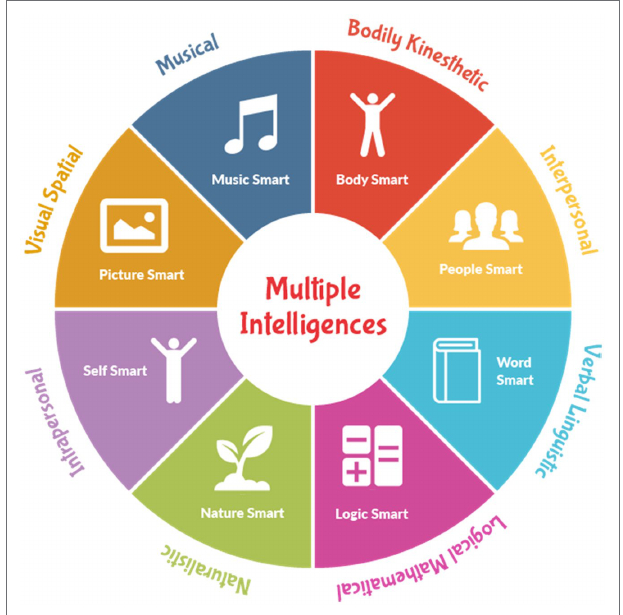
FIGURE 1 | Types of intelligence (Reproduced with permission from Gardner,